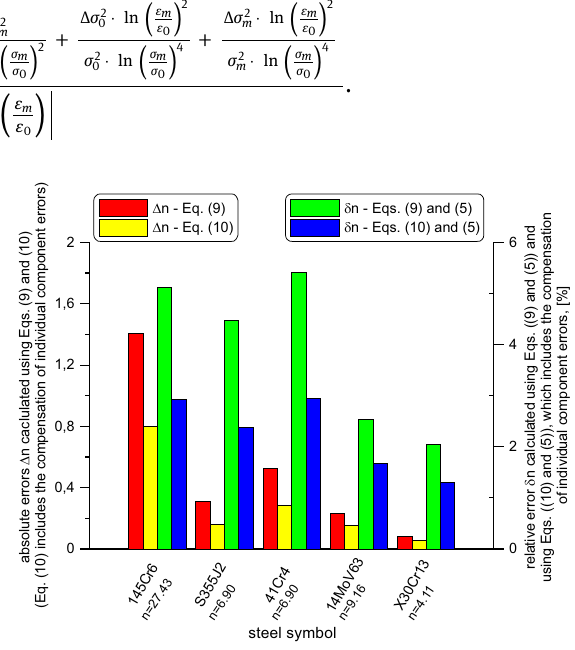
Figure A1: Comparison of the absolute and relative errors ( denoted as Δ n and δ n , respectively ) for strain hardening exponent n , for all steels used in this article.